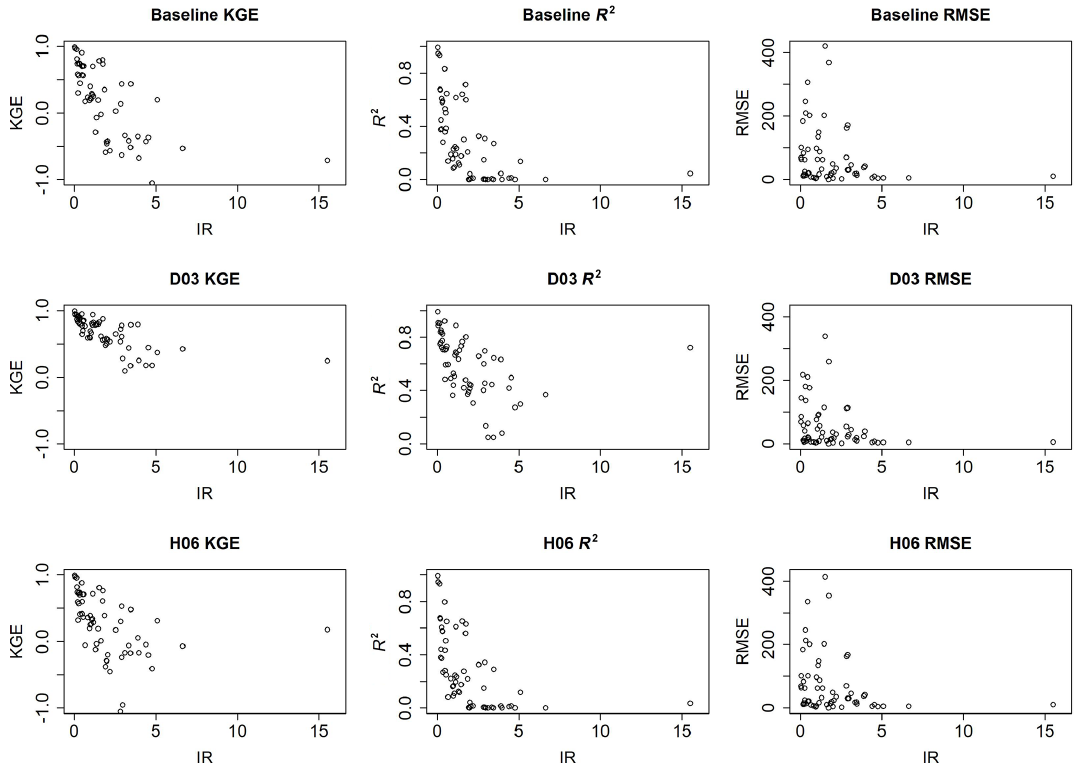
Figure 5. Comparison of IR and best KGE, R 2 , and RMSE from goodness-of-fit metrics for the baseline, D03, and H06.